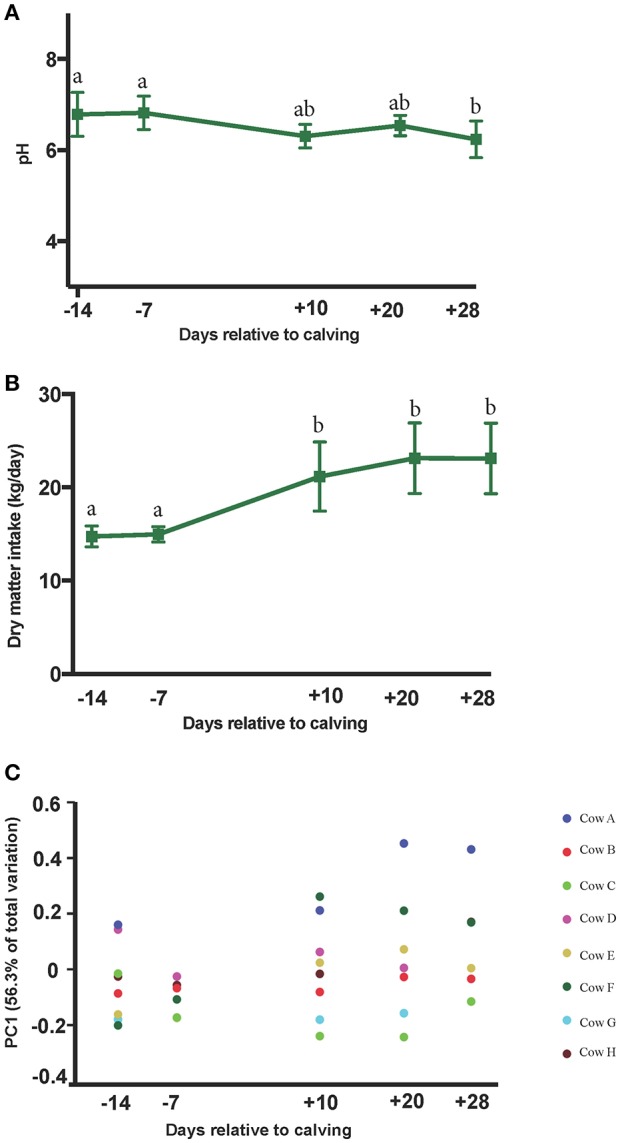
Peripartal shifts in dry matter intake, rumen pH and the ruminal microbial community. Changes in the (A) rumen pH, and (B) dry matter intake are plotted against sampling time points. Superscripts denote significant differences (P < 0.05) between the means and error bars denote the 95% confidence intervals. (C) Weighted UniFrac distances of ruminal microbial communities were minimal prepartum and increased postpartum. Colored circles are indicative of individual cows. Y axis shows the percentage of variation among communities explained by first principal component (PC1).